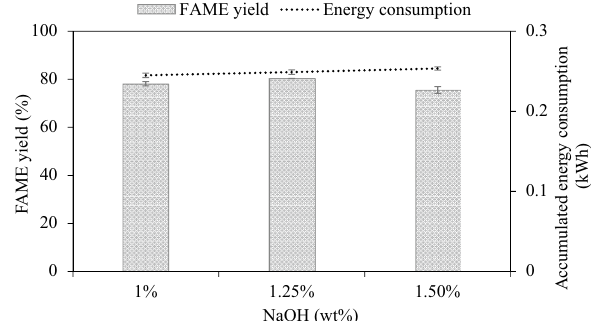
Figure 8. Effect of catalyst loading on WCO-derived FAME yield at steady state (2000 mL, 50 mL/min, 1 wt% NaOH, 62–63 °C).